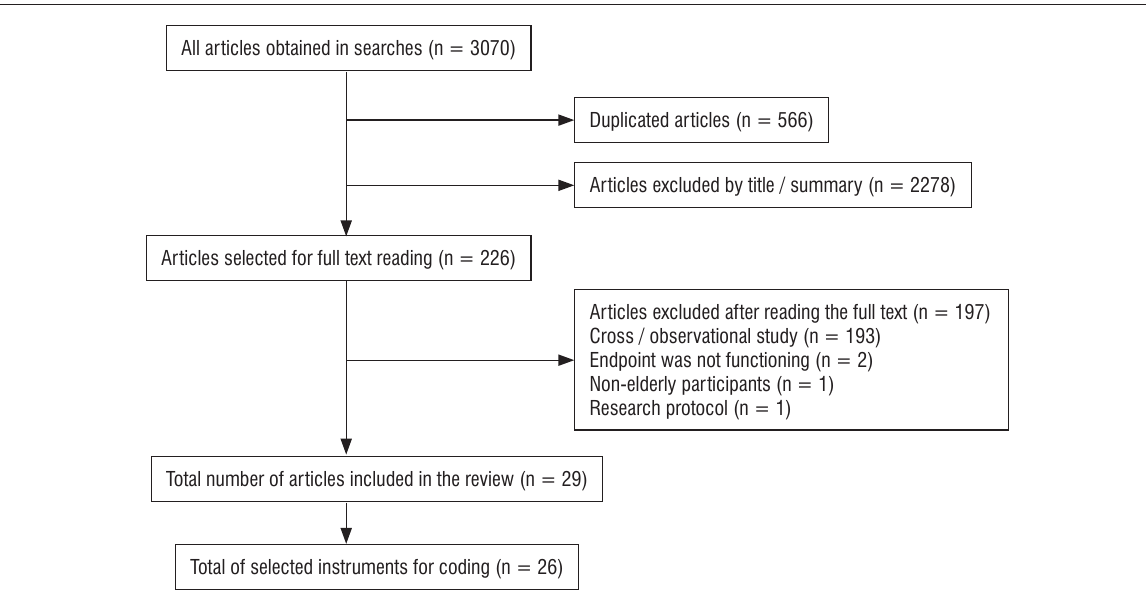
Figure 1 - Selection flowchart of review articles.